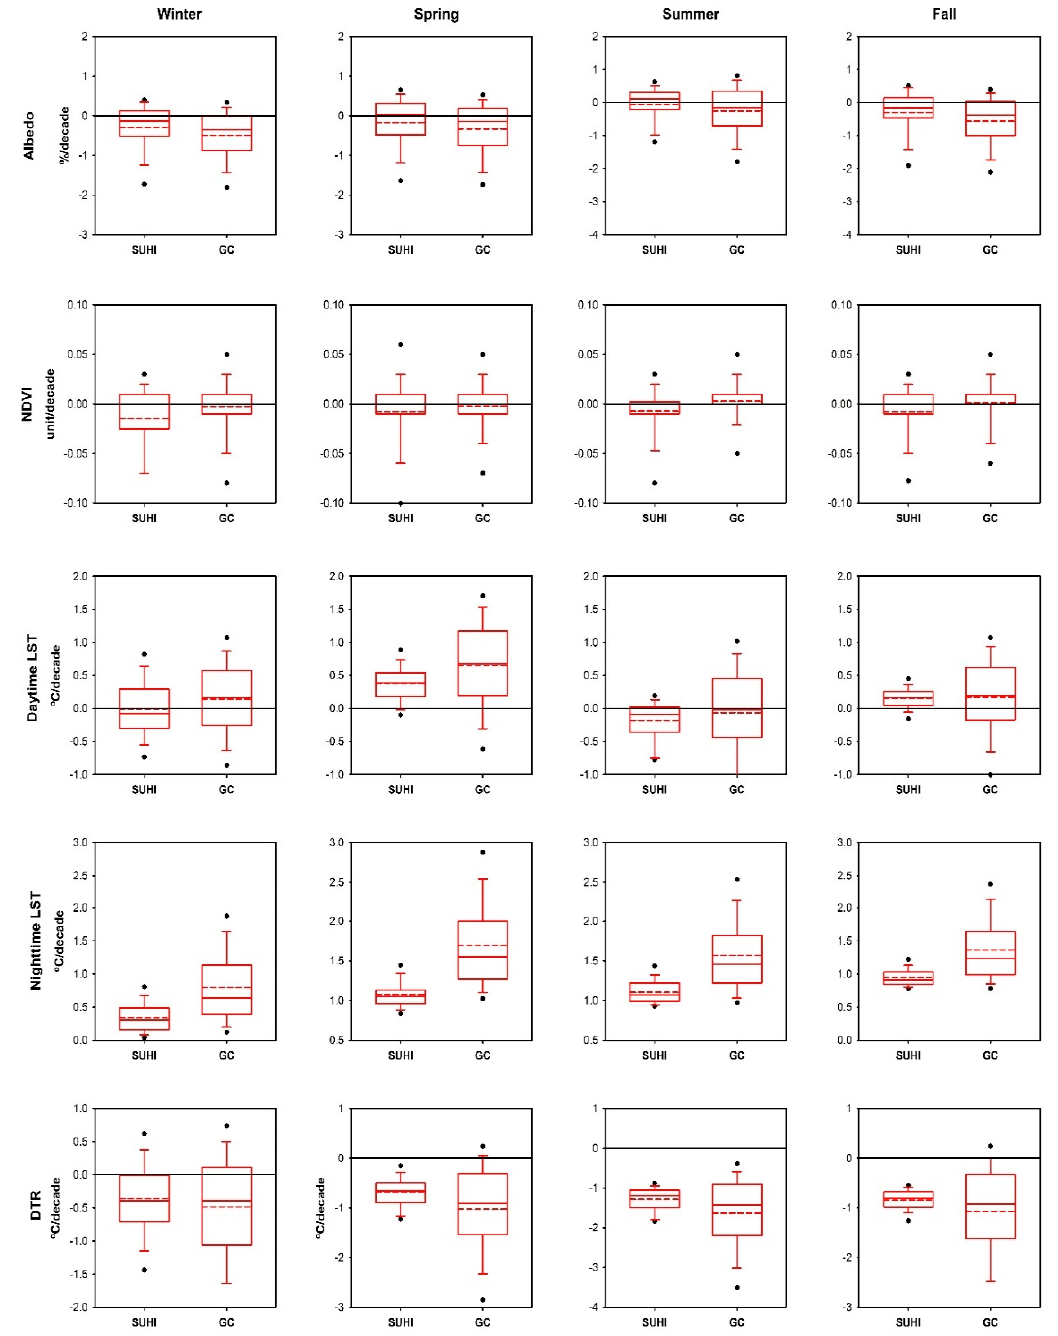
Figure 11. Amount of change in the different environmental and climatic variables calculated for SUHI against other parts of Greater Cairo (GC). against other parts of Greater Cairo